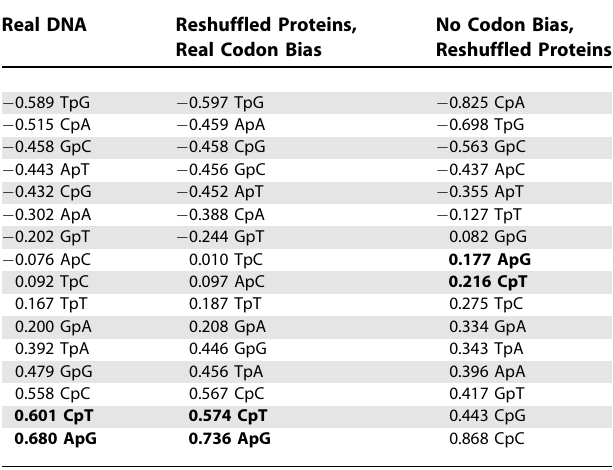
Table 3. Correlation Coefficients R between OGT and DNA Sequence Correlation Function c ij for the 16 Combinations of Nucleotides i,j in 83 Genomes Real DNA Reshuffled Proteins, Real Codon Bias